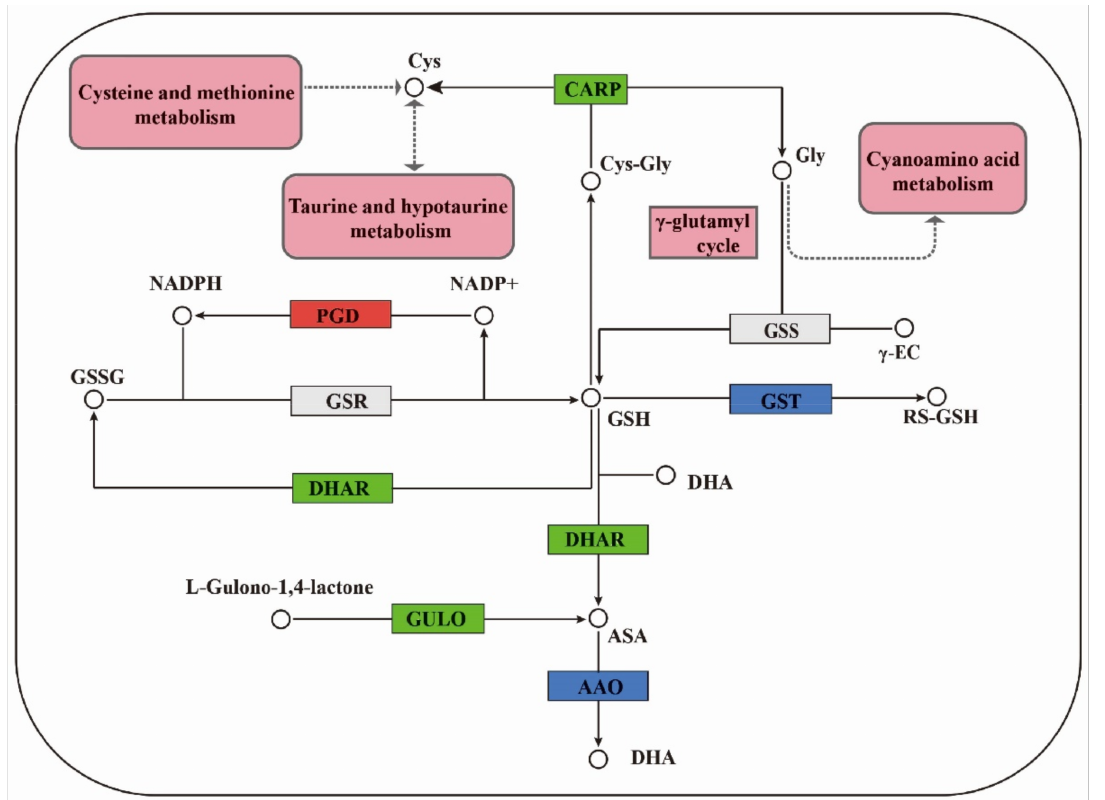
Figure 12. Diagram of the GSH cycle pathway in F and S cell lines of Korean pine. Note: Cys: L-cysteine; Cys-gly: L-cysteinylglycine; Gly: glycine; RS-GSH: R-S-glutathione; γ -GT: gamma- glutamyltranspeptidase; γ -EC: γ -glutamylcysteine; RS-GSH: R-S-glutathione; GSH: Glutathione; GSSG: oxidized glutathione; ASA: ascorbic acid; DHA: dehydroascorbic